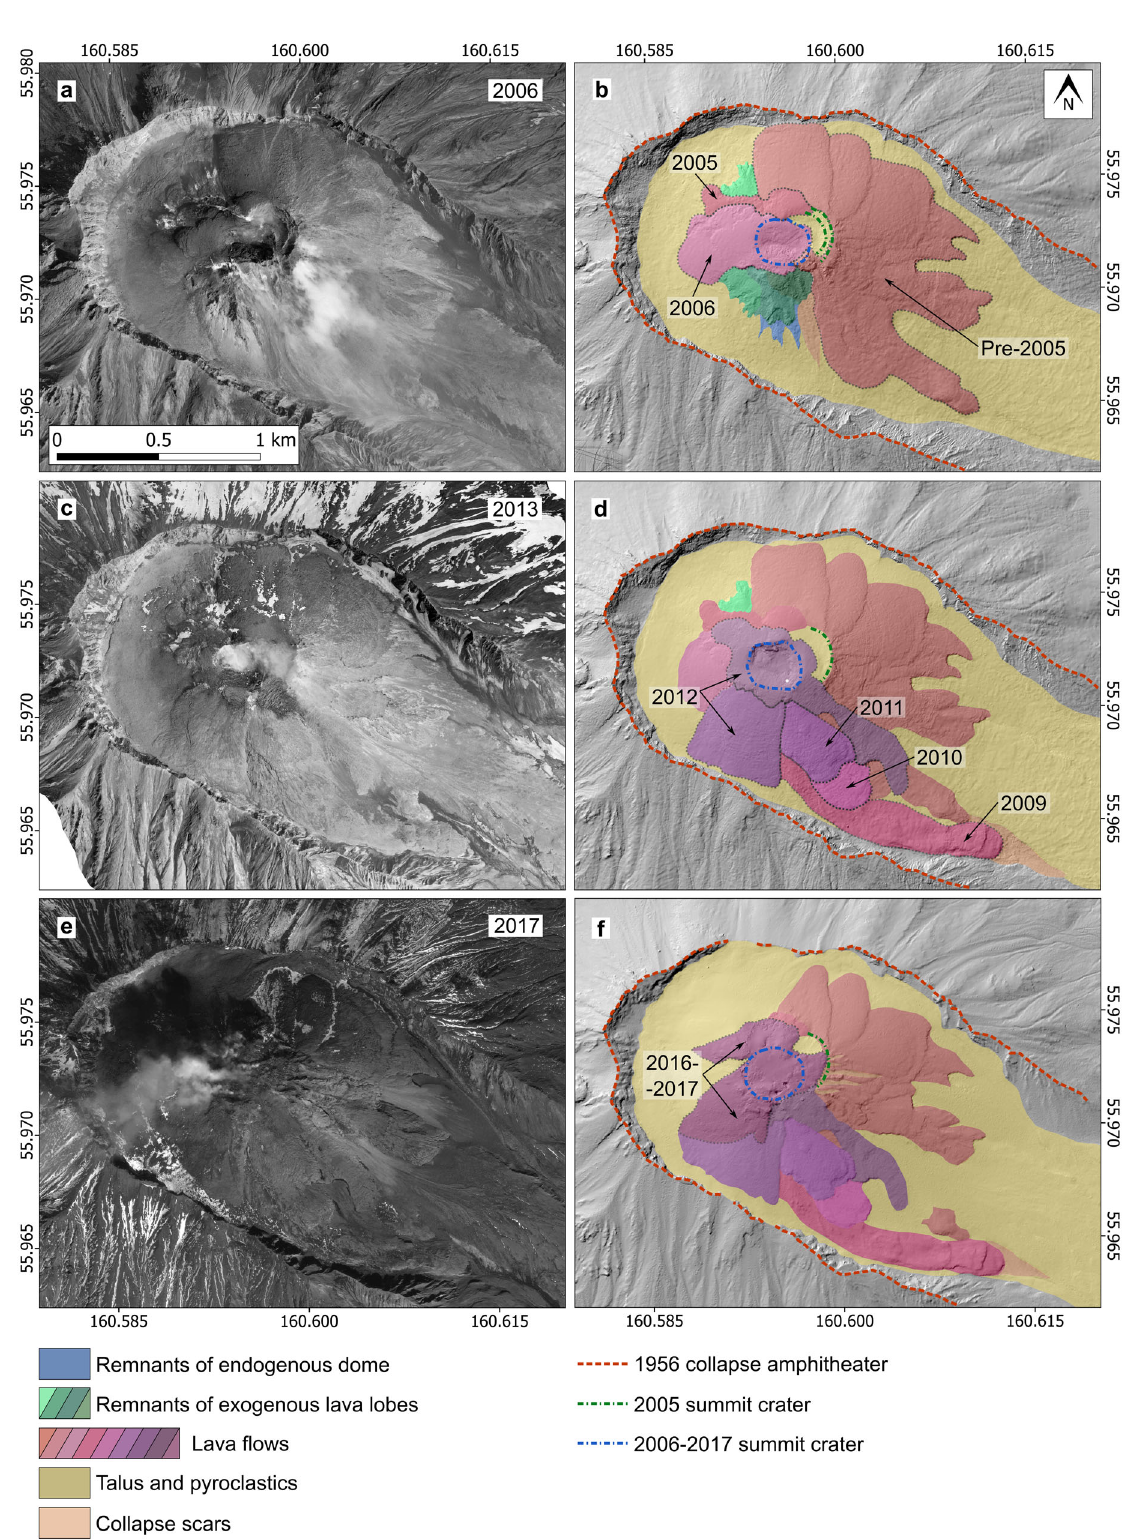
Fig. 5 Establishment of symmetric stratocone in 2006 – 2017. Aerial a , c and Pléiades satellite e orthophotos from 2006, 2013, and 2017, and the derived hillshade maps b , d , f . Please note that the dome complex as well as the base of the amphitheater became gradually buried beneath multiple lava fl ows and pyroclastic deposits, and a summit crater localized at a stable